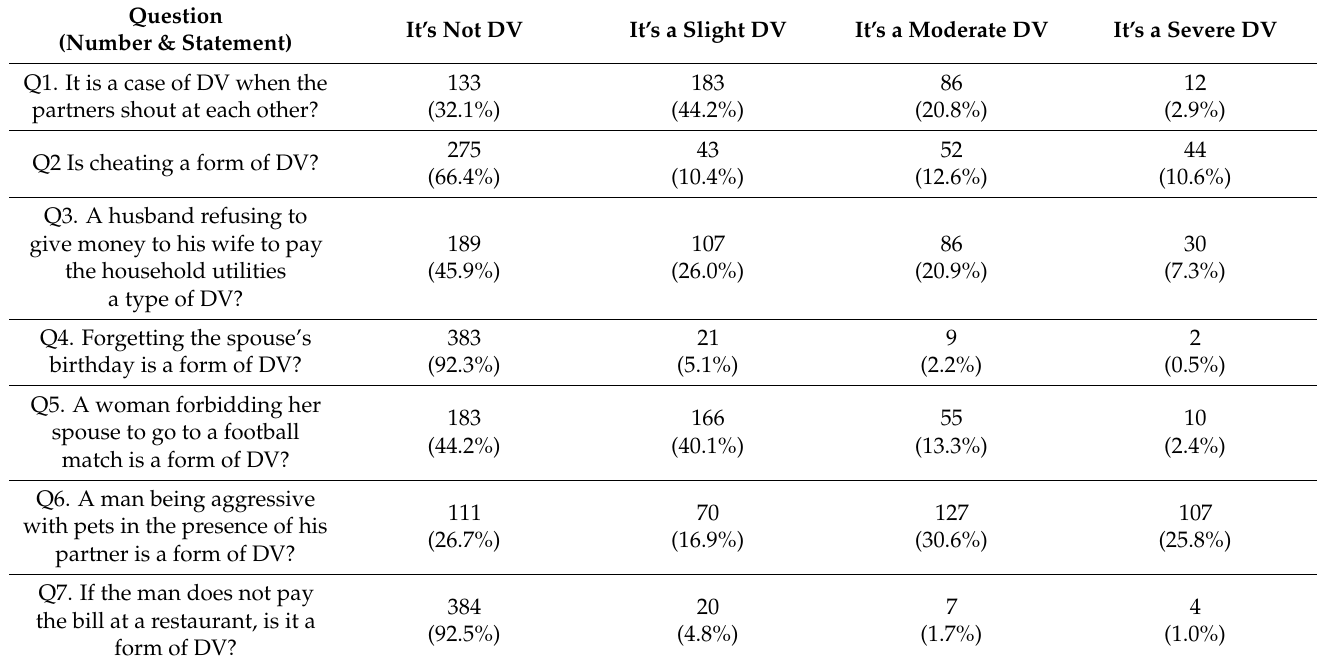
Table 1. Answers to the first seven